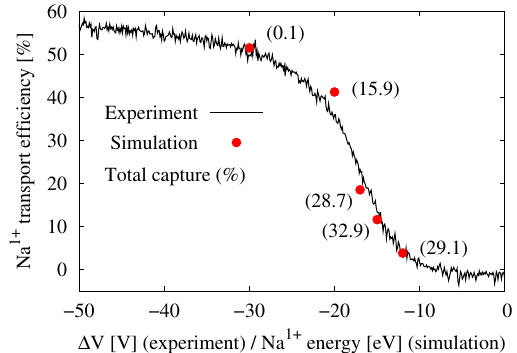
FIG. 2. Transport efficiencies of Na 1 þ ions through the plasma (simulation and experiment) and simulated total capture effi- ciency as a function of the incident ion energy. A plasma density of 4 . 4 × 10 11 cm − 3 and ion temperature of 0.5 eV were assumed for the simulation. The experimental data corresponds to 470 W microwave